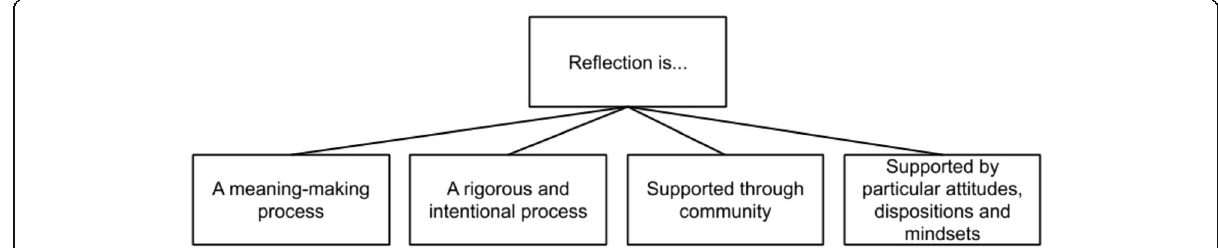
Fig. 1 This graphic is an original depiction of the components of reflection from Rodgers ’ (2002a) work on the reflective cycle in